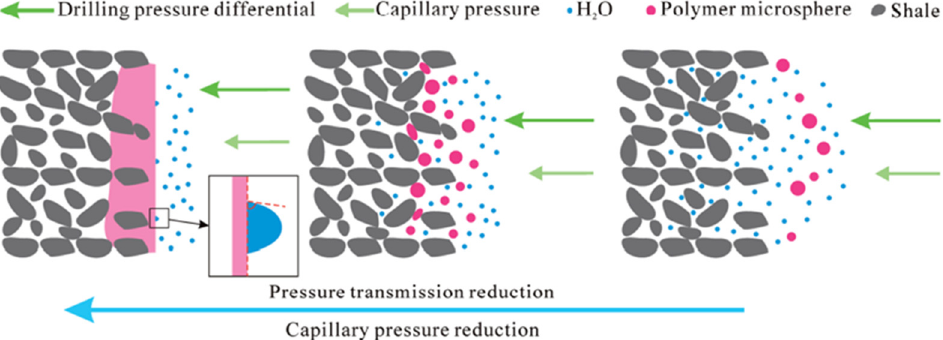
Figure 14. Pore and fracture plugging mechanism of nanoscale polymer microspheres for shales. (Reprinted/adapted with permission from Ref. [71], 2018, Xu et al.).